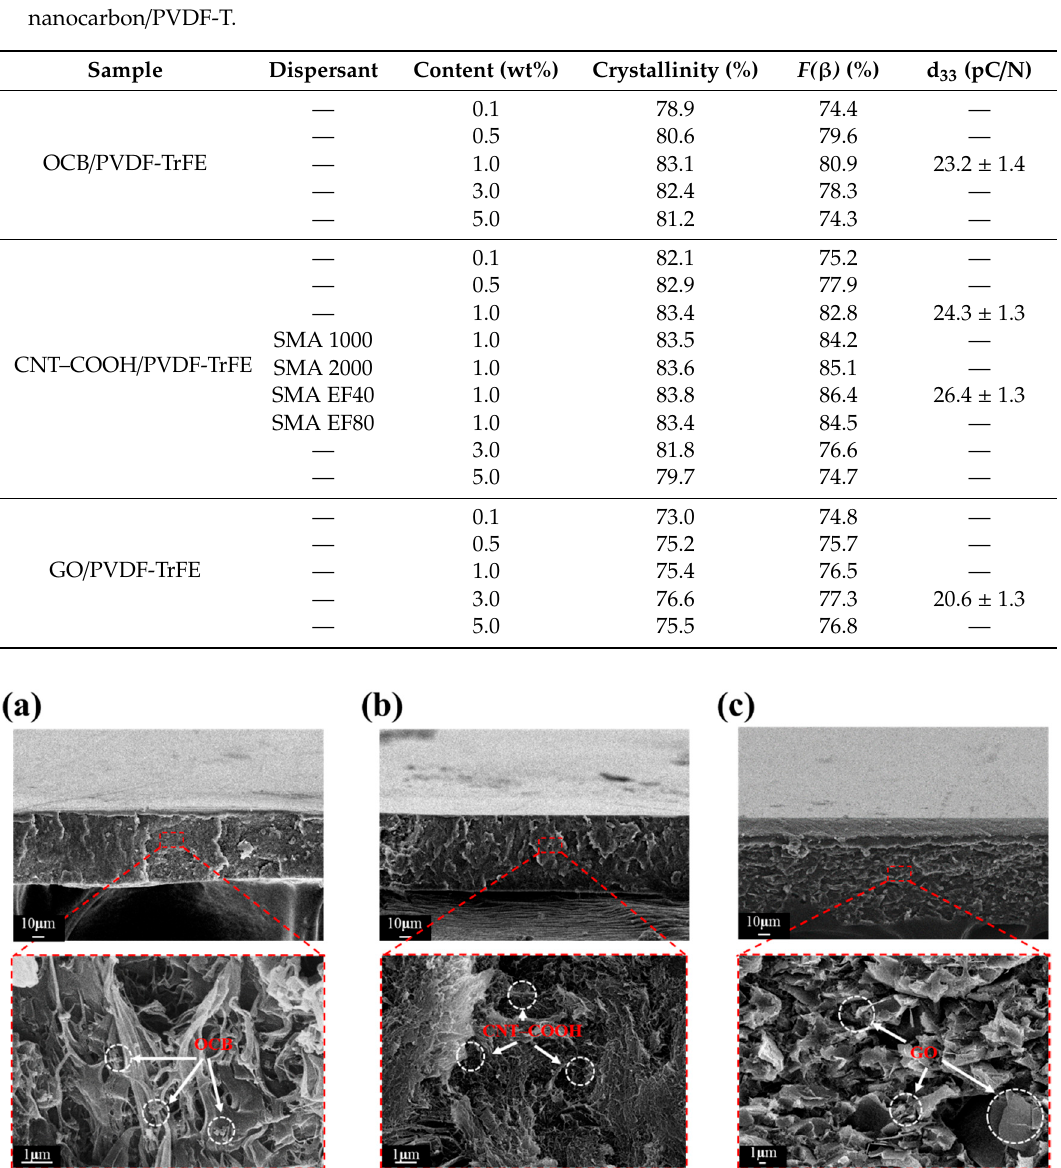
Figure 4. Scanning electron microscopy (SEM) cross-sectional images of the piezoelectric composite films: ( a ) OCB/PVDF-T 1 wt%, ( b ) CNT–COOH/PVDF-T 1 wt%, and ( c ) GO/PVDF-T 3 wt%.